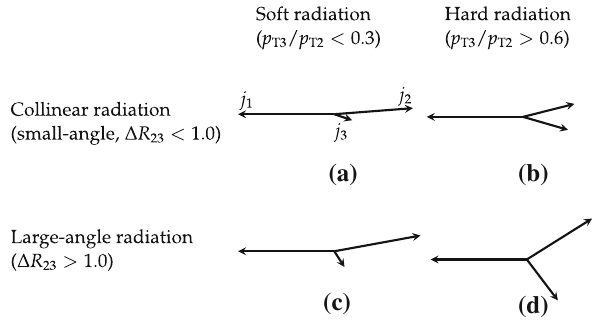
Fig. 1 Four categories of parton radiation. a Soft and small-angle radi- ation, b hard and small-angle radiation, c soft and large-angle radiation, d hard and large-angle